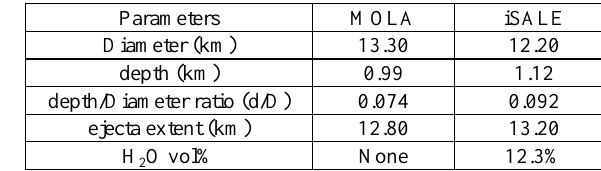
Table 2. Comparison between the results of observations and iSALE